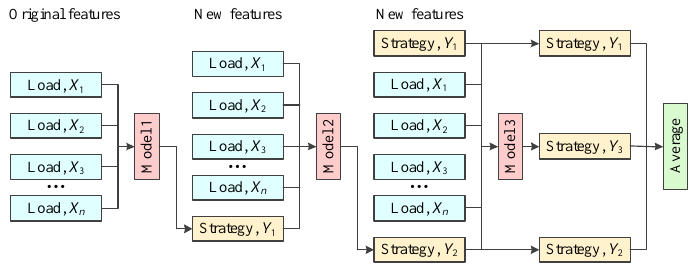
Figure 1. The framework of the proposed method.